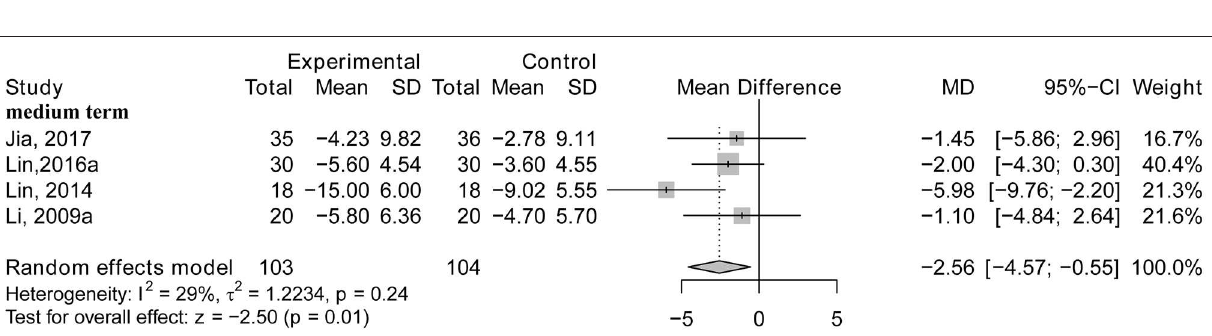
FIGURE 7 | The forest plot of ADAS-cog of acupuncture vs. drug therapy. Lin (2016a), acupuncture vs. Donepezil; Li (2009a), acupuncture vs. Yizhijiannao. (see Figure 11 ). In addition, only one trial (Gu et al.,